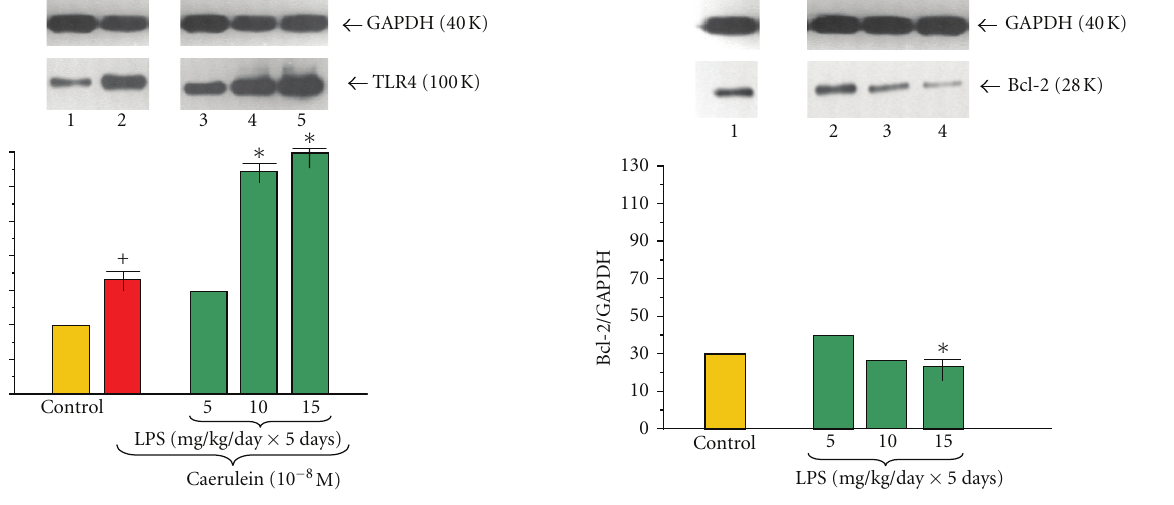
Figure 3: Western blot analysis of Bcl-2 protein level in the adult rat pancreatic acinar cells under basal conditions (lane 1), treated in the infant animals by lipopolysaccharide ( Escherichia coli ) at the doses of 5mg/kg/day × 5 days (lane 2), 10mg/kg/day × 5 days (lane 3), and 15 mg/kg/day × 5 days (lane 4) after 5 hours of incubation. Asterisk indicates significant ( P < 0 . 05) change, as compared to the control group. The blots were stripped and probed with GAPDH to document equal protein loading. All presented results were obtained in 4 consecutive experiments and are representative for the observed